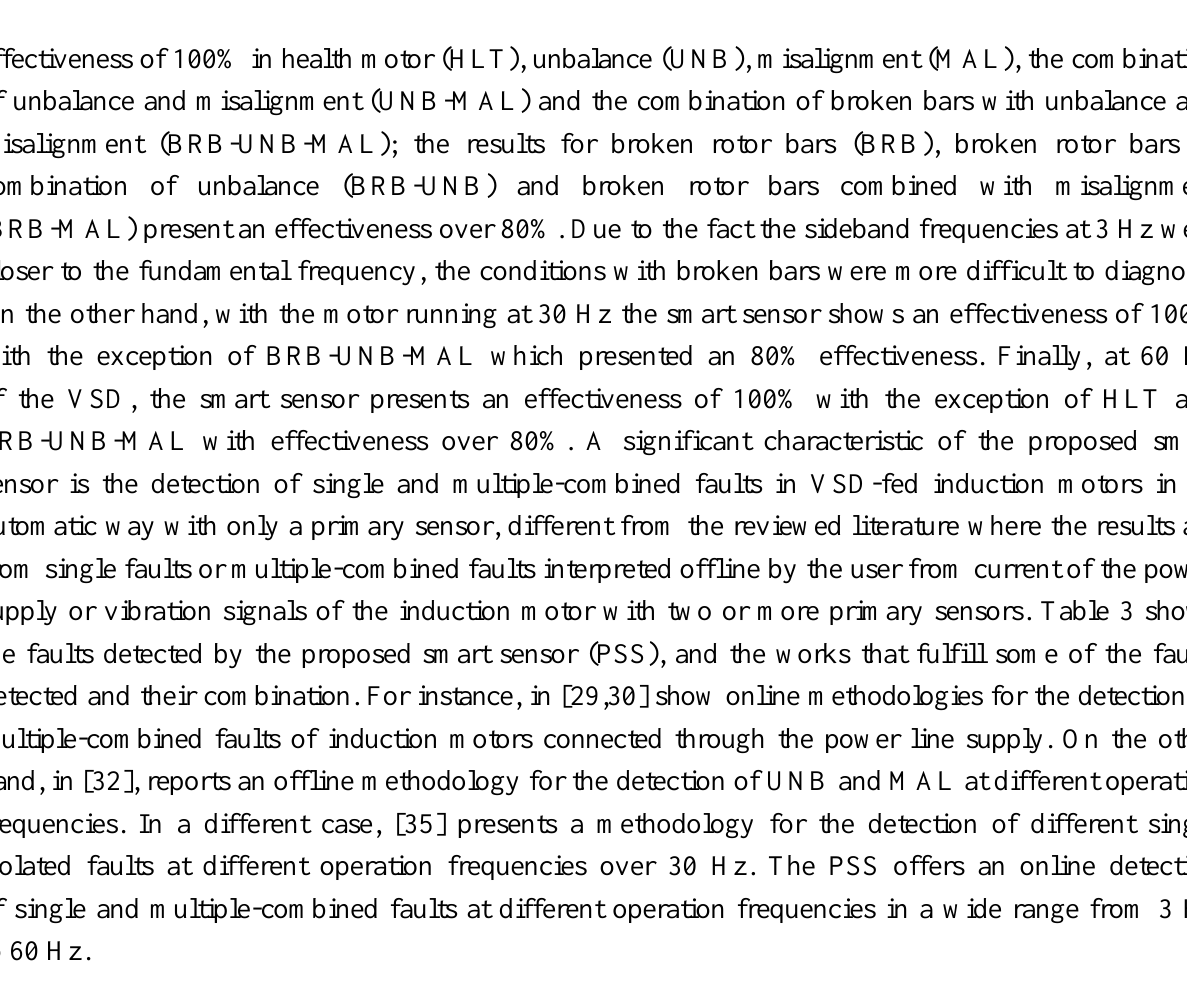
Table 3. Comparison between proposed smart sensor (PSS) and reviewed